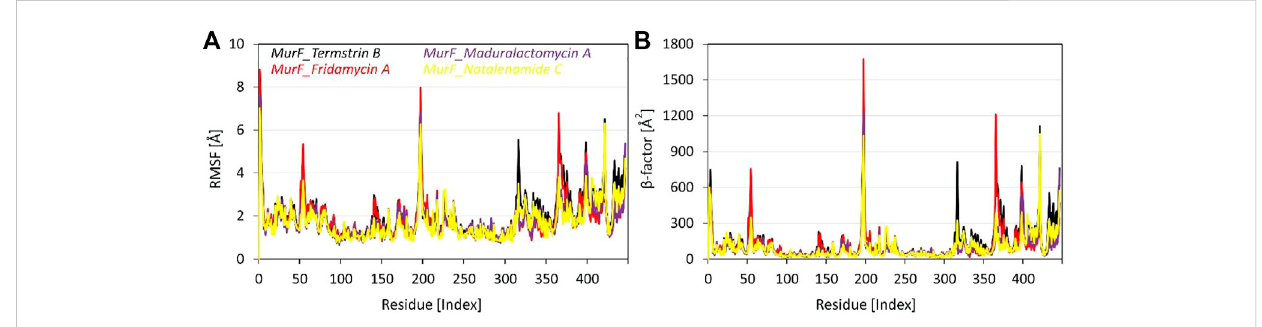
FIGURE 4 Root means square fl uctuation and β -factor analysis of the MurF protein of A. baumannii after 200 ns of molecular dynamics simulations. Where (A) represents the line RMSF graph for residues of MurF protein while (B) represents the β factor values of each residue while bound to the candidate compounds within the active site. The line graph is also enriched with colour-coded legends for each